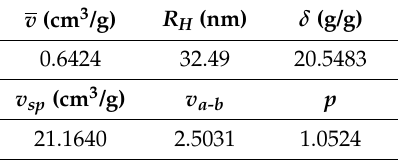
Table 3. Hydrodynamics data of BG solutions ( v , R H , v sp , v a-b , p , δ , and p ).